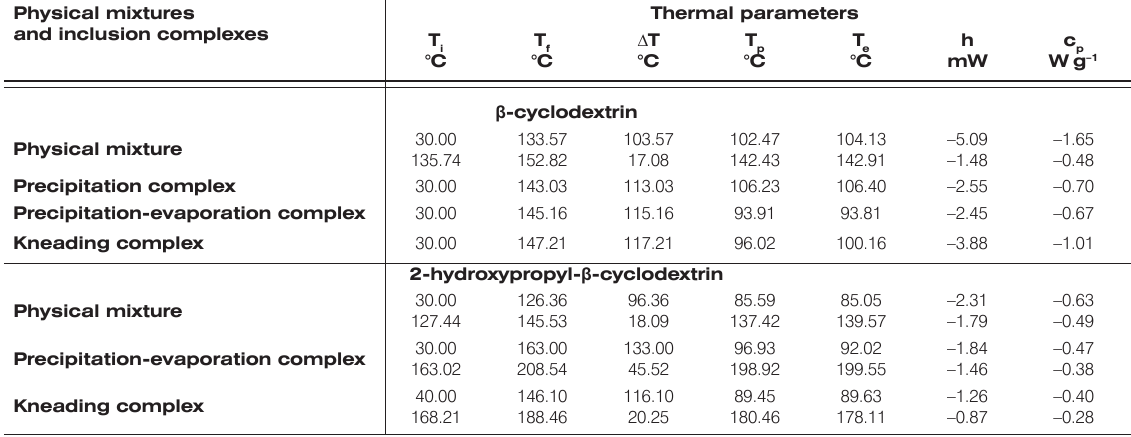
Table 1. DSC data set for physical mixtures and inclusion complexes of salicylamide.